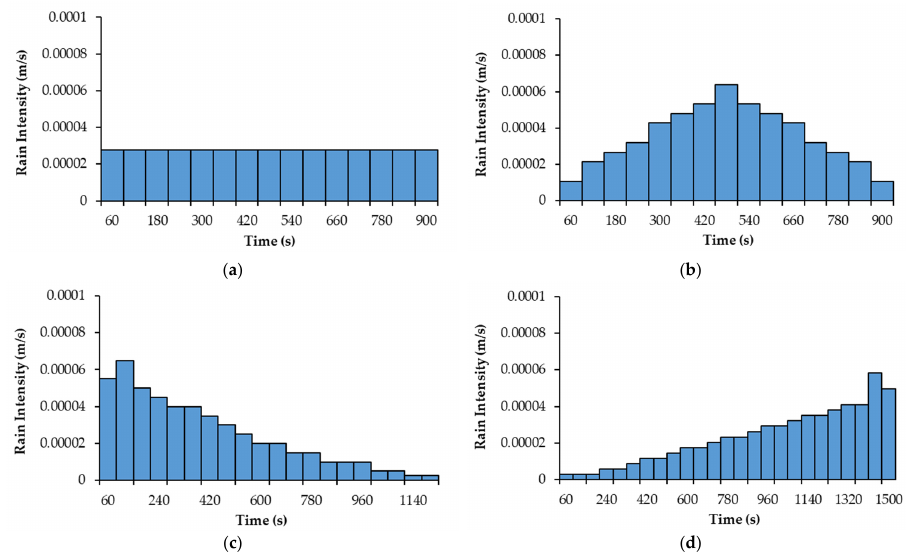
Figure 2. Rain intensity distributions of rainfall events with various patterns, durations, and total rainfall depths: ( a ) 15 min-constant; ( b ) 15 min-normal; ( c ) 20 min-descending; ( d ) 25 min-ascending. The pump was modeled as a sinkhole in the analyses. Thus, an outflux boundary condition was set to the pump’s boundary. The pump’s outflux is the discharge per unit area per unit time [m 3 /m 2 s or m/s].